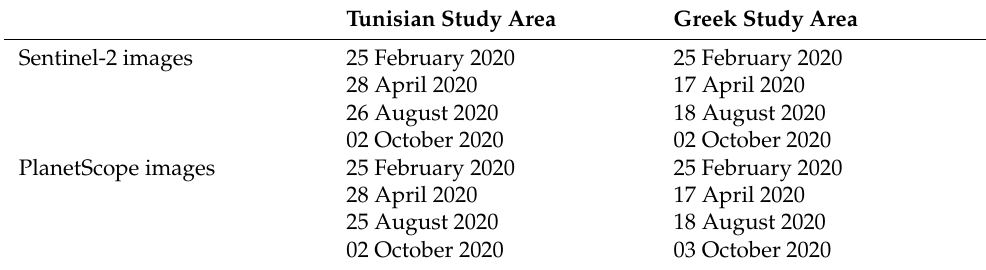
Table 2. Satellite imageacquisition